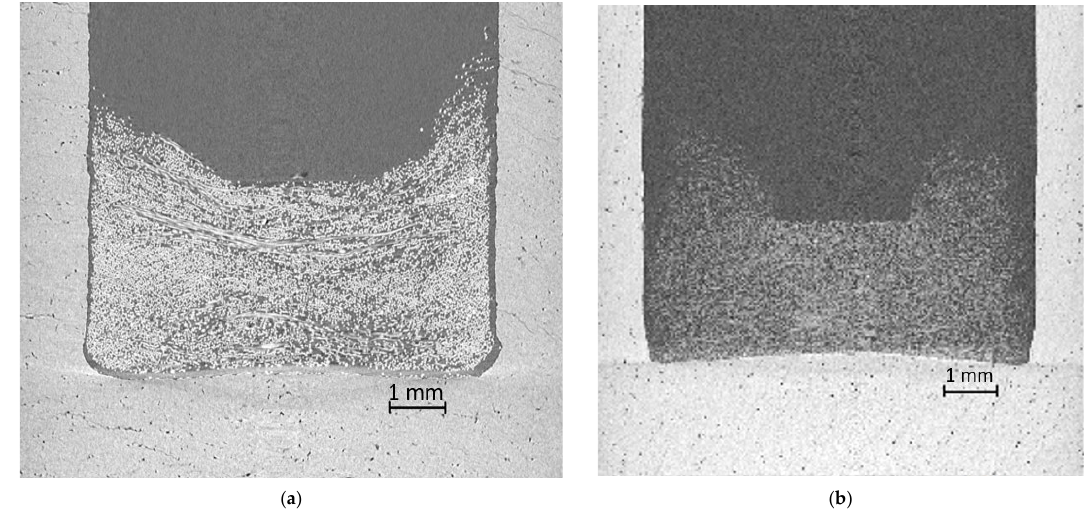
Figure 10. Tomographic images after ТМА : ( a ) PCS fiber and ( b ) PAN fiber [2]. Analysis of the PCS fiber sample composition using IR spectroscopy showed the sam- ple underwent significant changes during TMA; what remains in the IR absorption spec- trum of the fiber after TMA are signals at 780, 1220 cm −1 (Si–CH 3 bonds), 1440 cm −1 (C–H bonds), and 980 cm −1 (Si-CH 2 –Si bonds) [10,11] (Figure 11).